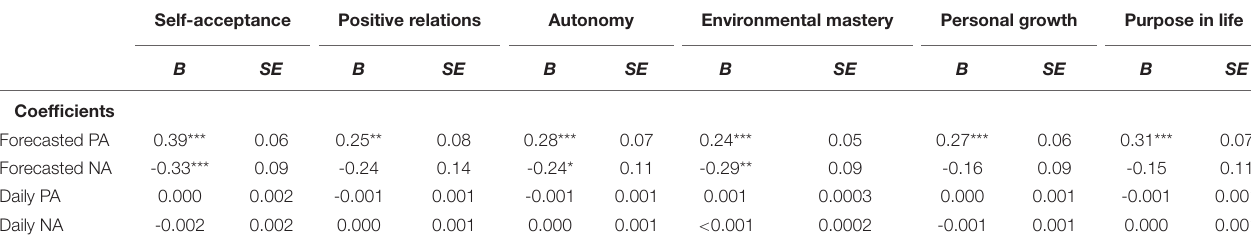
TABLE 4 | Generalized Estimating Equation (GEE) models introducing forecasted PA, forecasted NA, daily EMA-PA and daily EMA-NA as predictors of well-being subscales. Self-acceptance Positive relations Autonomy Environmental